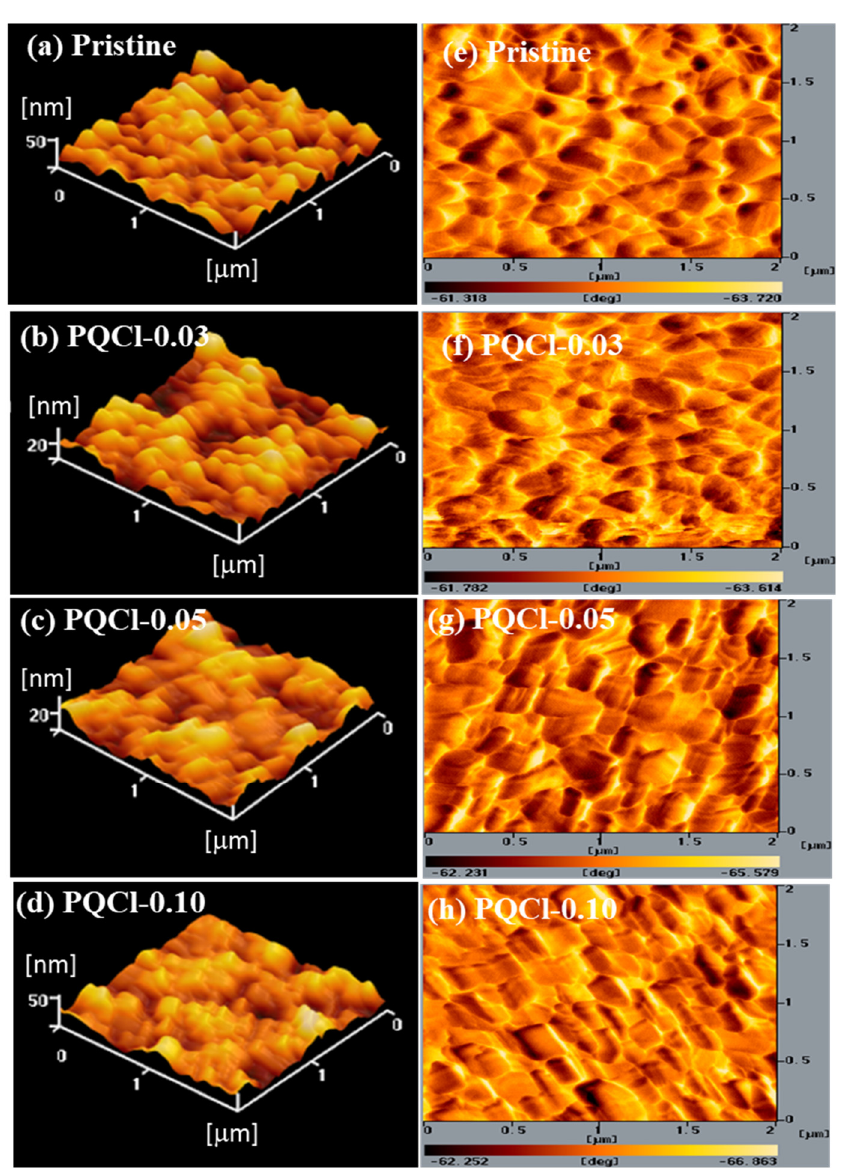
Figure 7. ( a – d ) Topographic and ( e – h ) phase AFM images of perovskite films deposited on ( a , e ) pristine and ( b , f ) PQCl-0.03–, ( c , g ) PQCl-0.05–, and ( d , h ) PQCl-0.10–modified